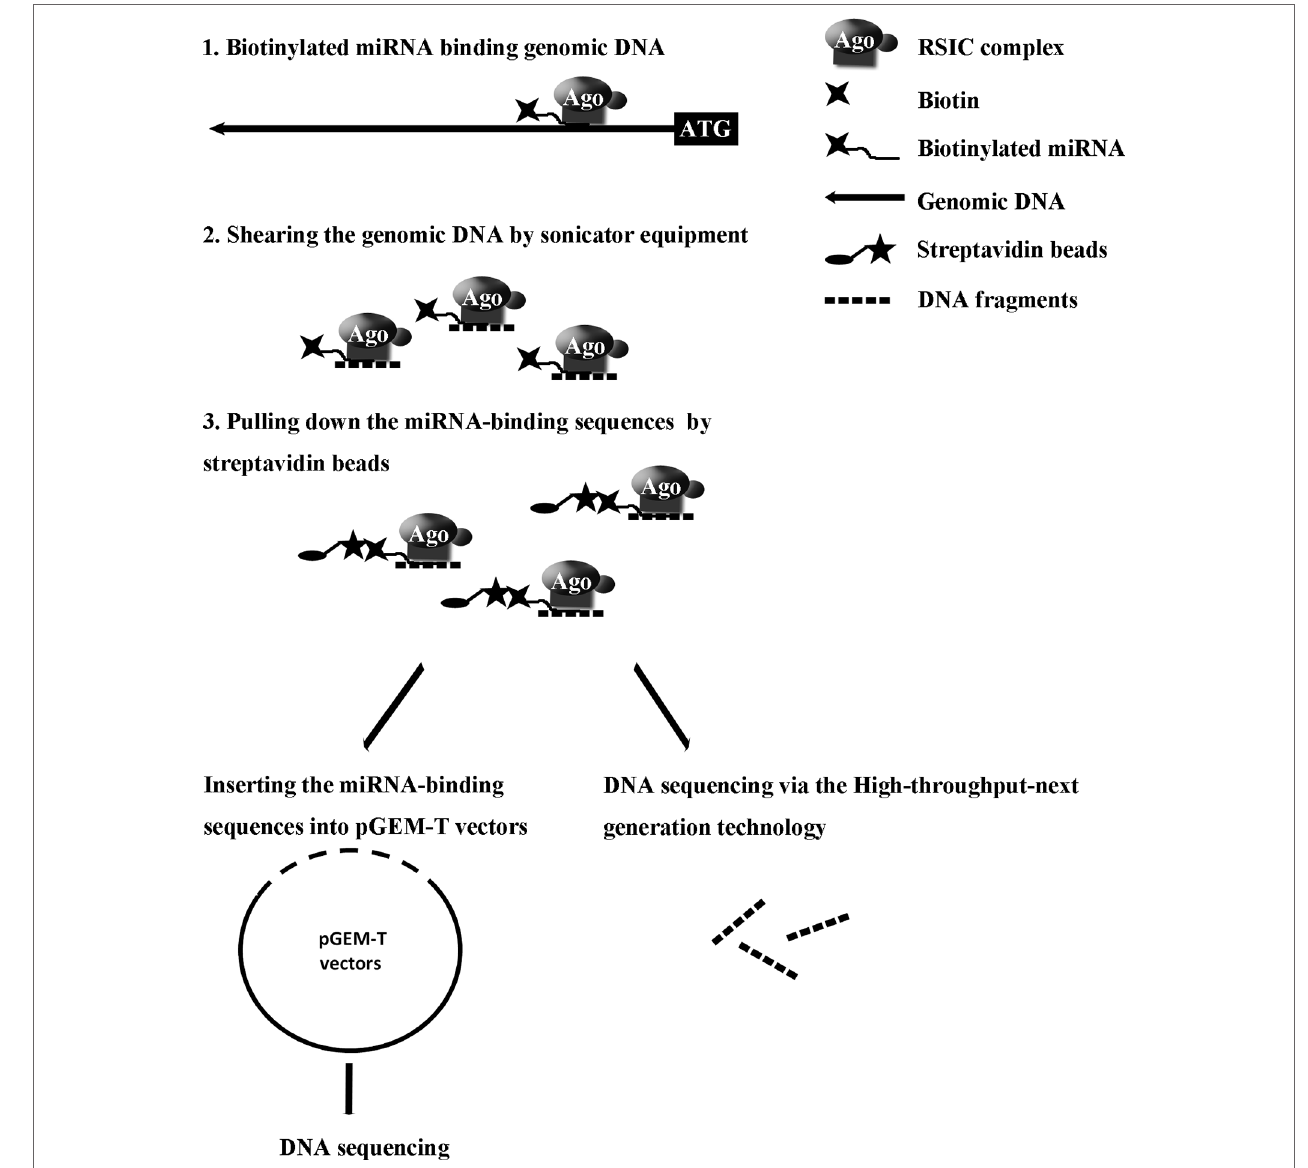
FIGURE 1 | Strategy for screening microRNA binding sequences in the whole genomic